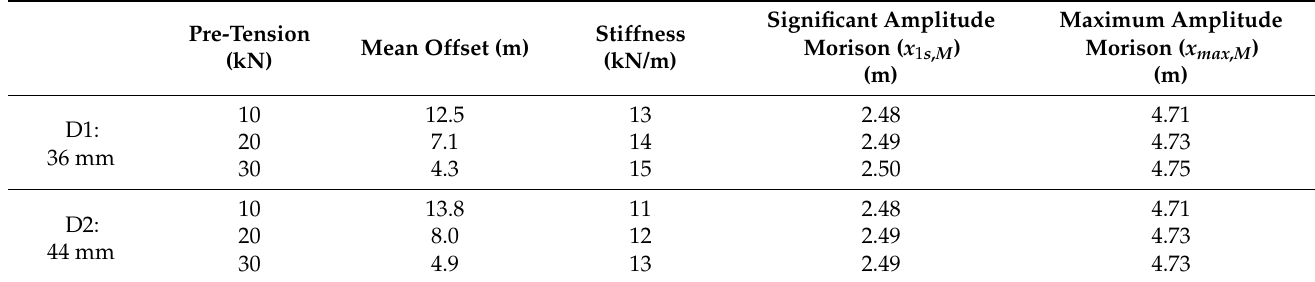
Table 10. Case 1, wave results Diffraction.